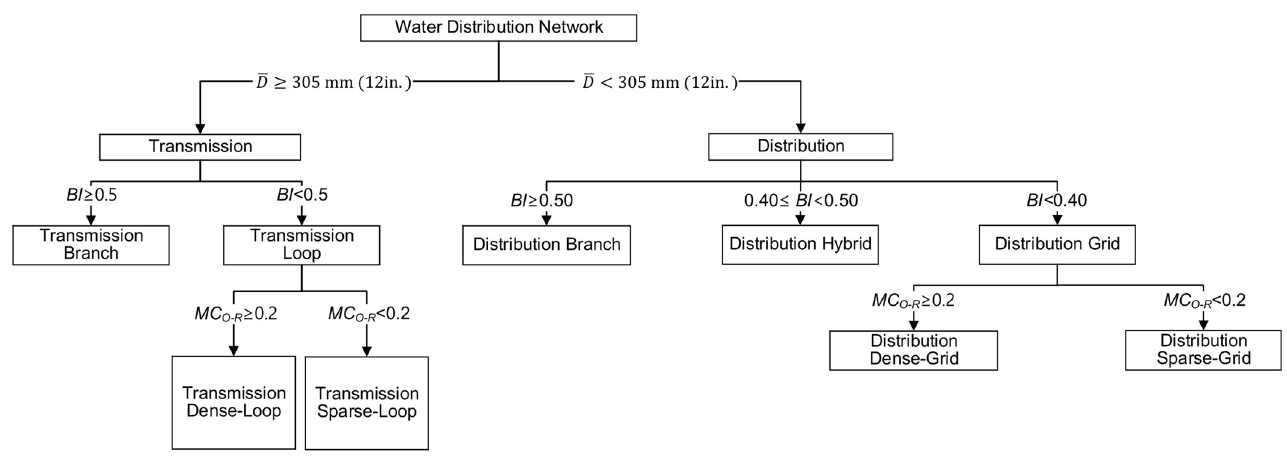
Figure 1. Water distribution network classification flowchart. D represents the length-weighted average pipe diameter, BI is the Branch Index, and MC O − R is the Meshedness Coefficient for the reduced network. Source: Hwang and Lansey [34].